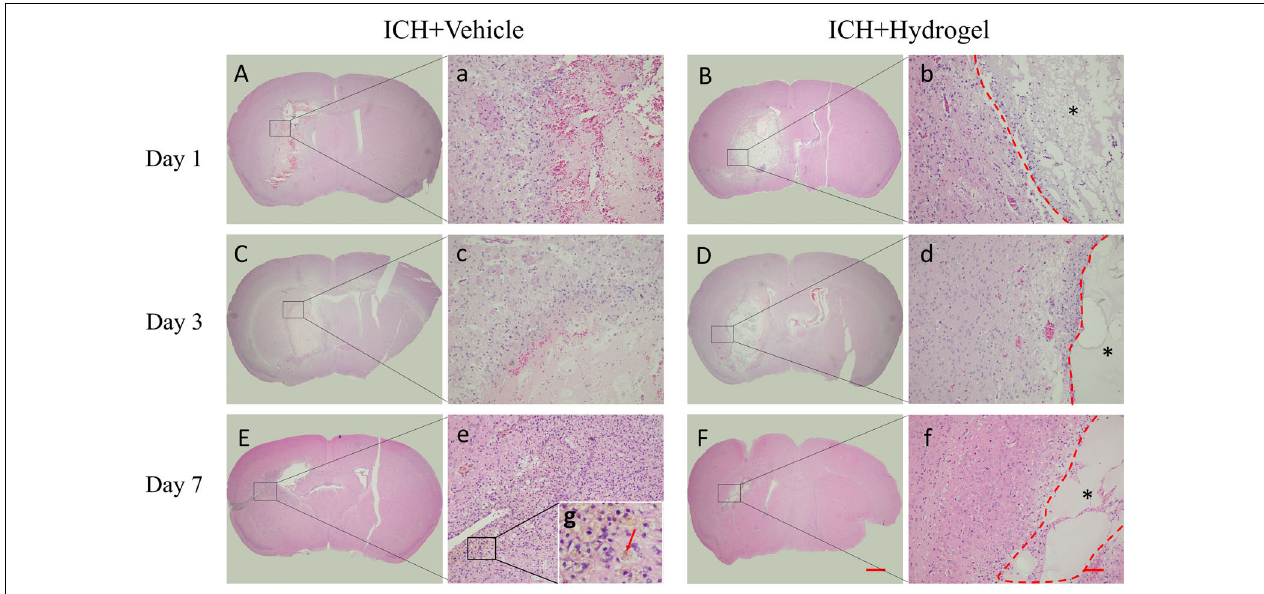
FIGURE 4 | H&E staining. (A–F) The overall morphology of the injured brain in different time-point after gelatin hydrogel injection, scale bar = 500 µ m. (a–f) Magnified images show the host tissue-lesion or gelatin hydrogel interface, scale bar = 50 µ m. (g) Local magnification image of hemosiderin deposition. *Represents the